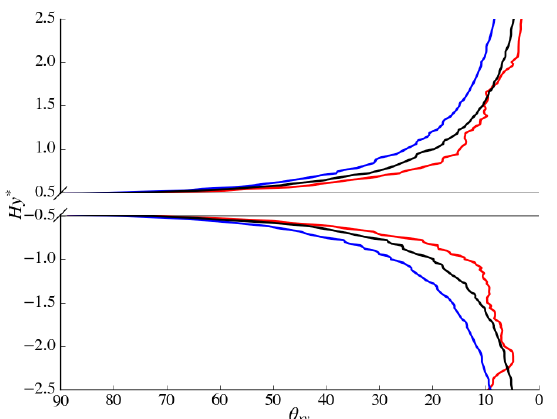
Figure 12. Ensemble averaged flow angle in front of the cylinder at ( − 0.5 H , H ∗ y ,0 ) computed from V ∗ x and V ∗ y . The red, blue and black lines represent 0 < a x , a x < 0 and a x = 0 cases, respectively.